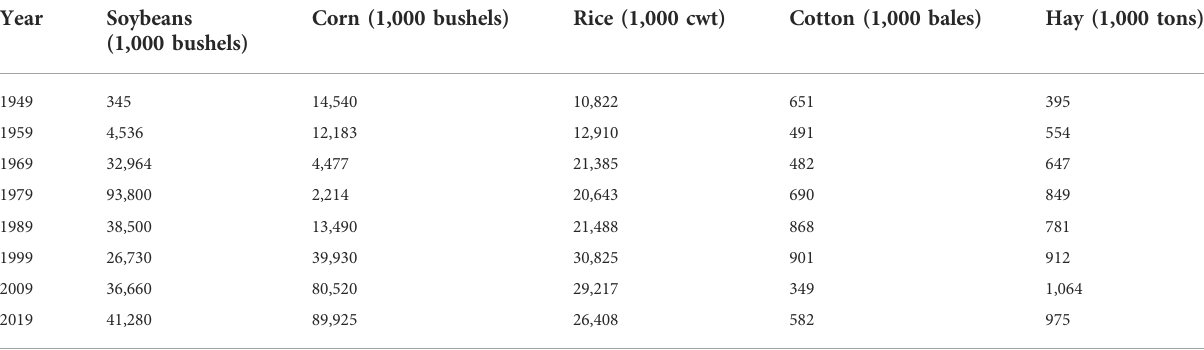
TABLE 3 As in Table 2, but for total production (source: USDA NASS 2020). Year Soybeans (1,000